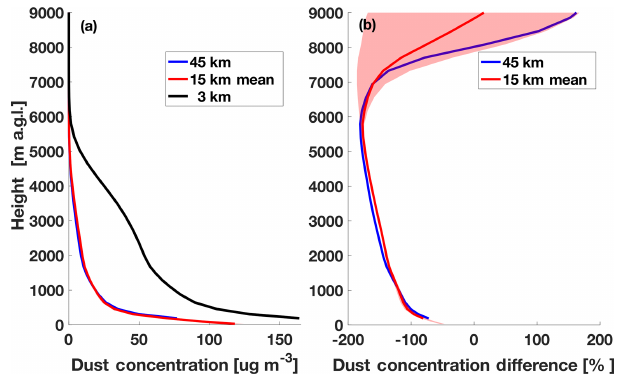
Figure 7. (a) Spatially and temporally averaged vertical dust con- centrations as well as (b) the percent difference between the 3km convection-permitting simulation and the simulations employing cumulus parameterizations. Plots are truncated at 9km as the val- ues above this height do not significantly vary from what is shown here. Colors and shading are identical to those used in previous fig- ures.